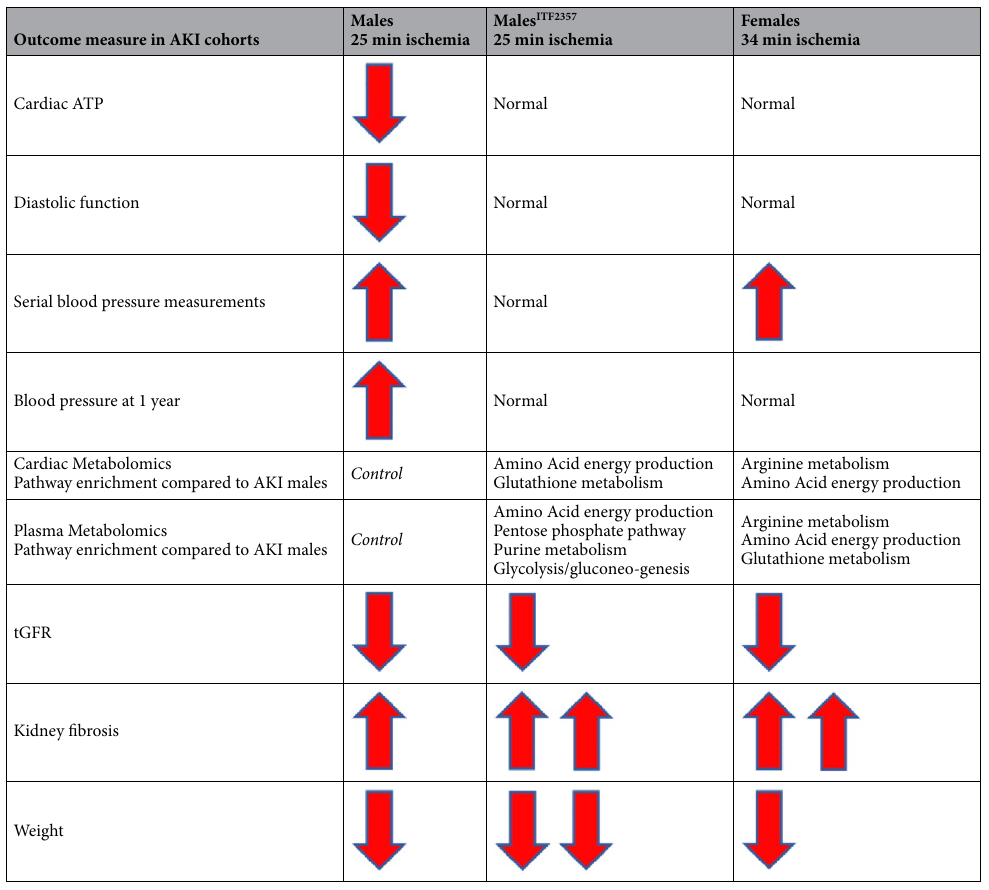
Table 3. Summary of major outcomes after AKI in male and female cohorts. Summary of major cardiorenal, metabolic and growth outcomes in AKI cohorts including males, males treated with ITF2357 and females. Adapted from Soranno et al. JACC 21